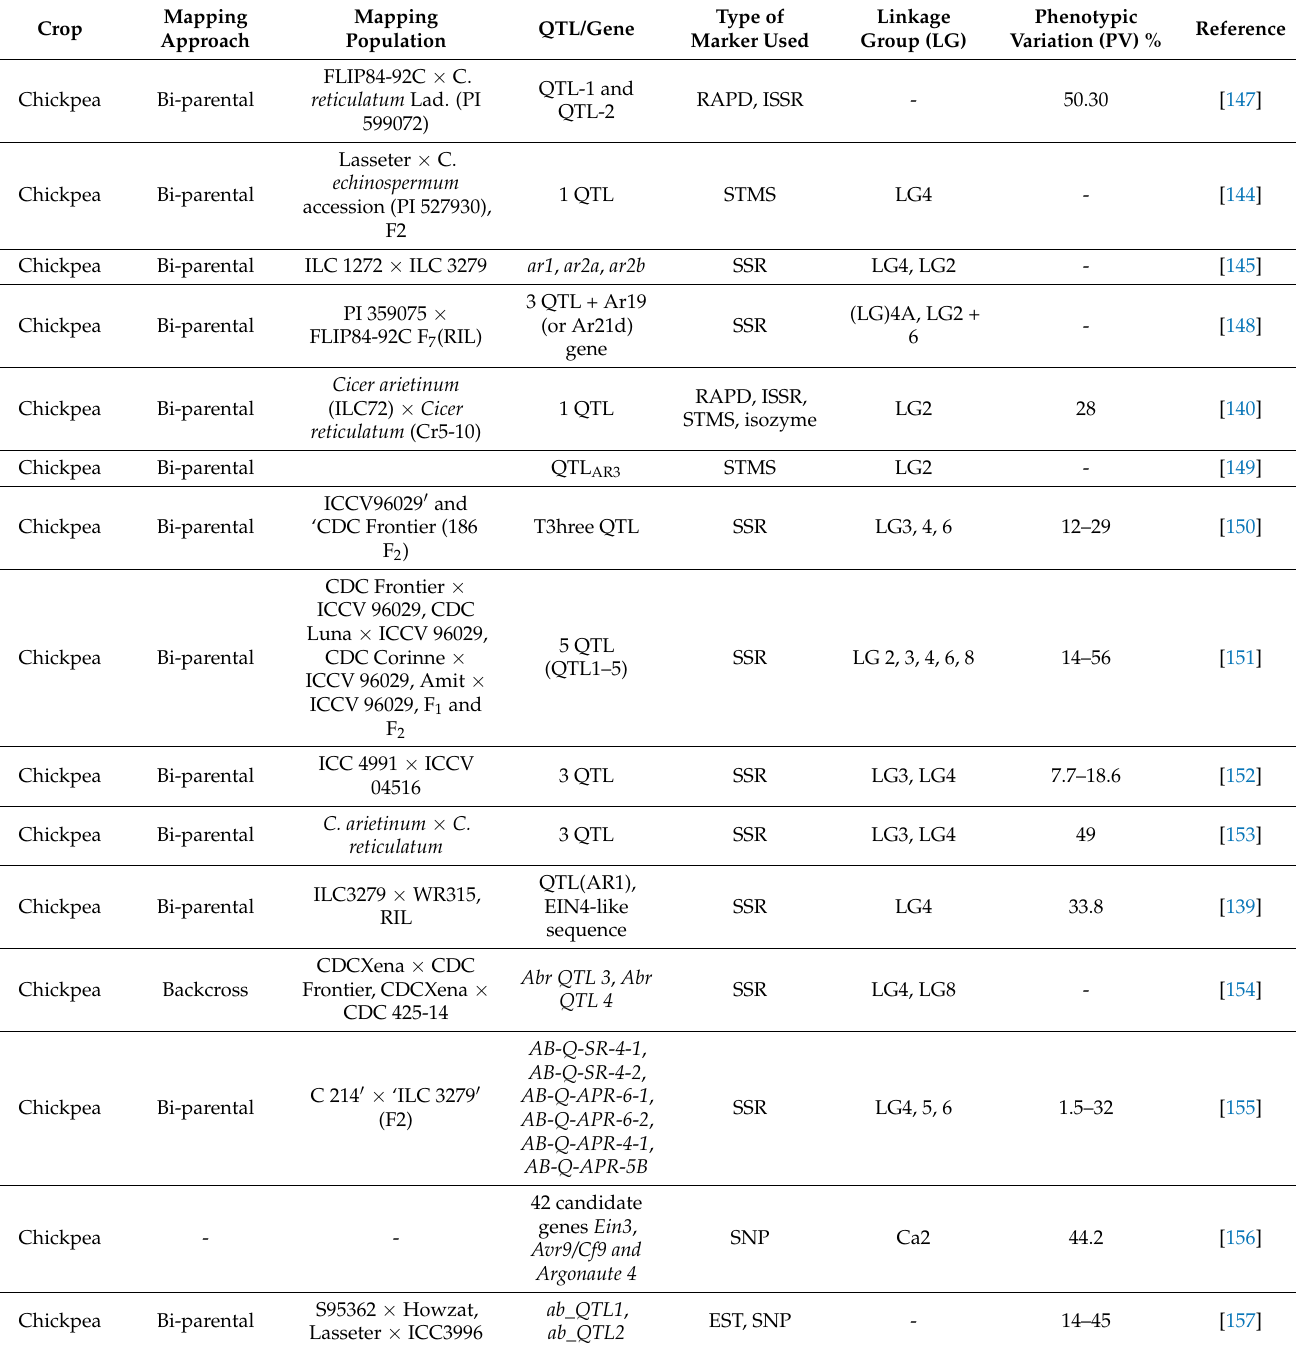
Table 3. List of Aschochyta blight resistant QTLs identified in various grain